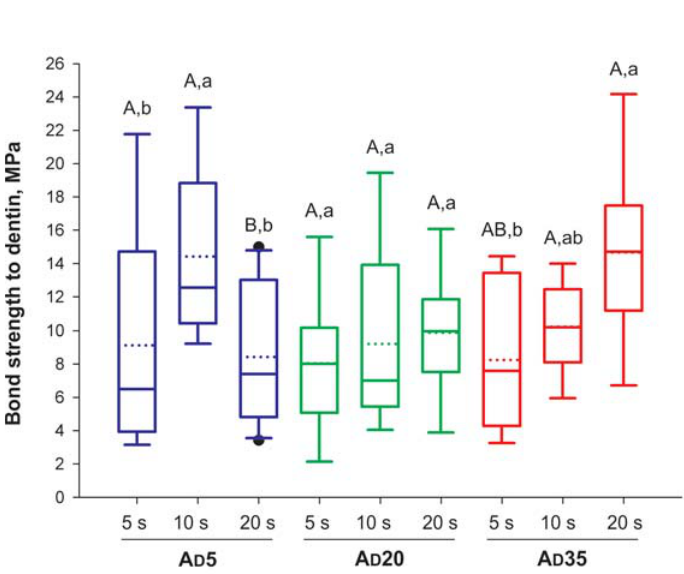
Figure 2- (cid:3)(cid:53)(cid:72)(cid:86)(cid:88)(cid:79)(cid:87)(cid:86)(cid:3)(cid:73)(cid:82)(cid:85)(cid:3)(cid:71)(cid:72)(cid:81)(cid:87)(cid:76)(cid:81)(cid:3)(cid:69)(cid:82)(cid:81)(cid:71)(cid:3)(cid:86)(cid:87)(cid:85)(cid:72)(cid:81)(cid:74)(cid:87)(cid:75)(cid:3)(cid:11)(cid:81)(cid:32)(cid:20)(cid:19)(cid:12)(cid:17)(cid:3)(cid:54)(cid:82)(cid:79)(cid:76)(cid:71)(cid:3)(cid:68)(cid:81)(cid:71)(cid:3)(cid:71)(cid:82)(cid:87)(cid:87)(cid:72)(cid:71)(cid:3)(cid:75)(cid:82)(cid:85)(cid:76)(cid:93)(cid:82)(cid:81)(cid:87)(cid:68)(cid:79)(cid:3)(cid:79)(cid:76)(cid:81)(cid:72)(cid:86)(cid:3)(cid:90)(cid:76)(cid:87)(cid:75)(cid:76)(cid:81)(cid:3)(cid:72)(cid:68)(cid:70)(cid:75)(cid:3)(cid:69)(cid:82)(cid:91)(cid:3)(cid:76)(cid:81)(cid:71)(cid:76)(cid:70)(cid:68)(cid:87)(cid:72)(cid:3)(cid:87)(cid:75)(cid:72)(cid:3)(cid:80)(cid:72)(cid:71)(cid:76)(cid:68)(cid:81)(cid:86)(cid:3)(cid:68)(cid:81)(cid:71)(cid:3)(cid:80)(cid:72)(cid:68)(cid:81)(cid:86)(cid:15)(cid:3) (cid:85)(cid:72)(cid:86)(cid:83)(cid:72)(cid:70)(cid:87)(cid:76)(cid:89)(cid:72)(cid:79)(cid:92)(cid:17)(cid:3)(cid:56)(cid:83)(cid:83)(cid:72)(cid:85)(cid:70)(cid:68)(cid:86)(cid:72)(cid:3)(cid:79)(cid:72)(cid:87)(cid:87)(cid:72)(cid:85)(cid:86)(cid:3)(cid:76)(cid:81)(cid:71)(cid:76)(cid:70)(cid:68)(cid:87)(cid:72)(cid:3)(cid:71)(cid:76)(cid:73)(cid:73)(cid:72)(cid:85)(cid:72)(cid:81)(cid:70)(cid:72)(cid:86)(cid:3)(cid:68)(cid:80)(cid:82)(cid:81)(cid:74)(cid:3)(cid:80)(cid:68)(cid:87)(cid:72)(cid:85)(cid:76)(cid:68)(cid:79)(cid:86)(cid:30)(cid:3)(cid:79)(cid:82)(cid:90)(cid:72)(cid:85)(cid:70)(cid:68)(cid:86)(cid:72)(cid:3)(cid:79)(cid:72)(cid:87)(cid:87)(cid:72)(cid:85)(cid:86)(cid:3)(cid:76)(cid:81)(cid:71)(cid:76)(cid:70)(cid:68)(cid:87)(cid:72)(cid:3)(cid:86)(cid:76)(cid:74)(cid:81)(cid:76)(cid:191)(cid:70)(cid:68)(cid:81)(cid:87)(cid:3)(cid:71)(cid:76)(cid:73)(cid:73)(cid:72)(cid:85)(cid:72)(cid:81)(cid:70)(cid:72)(cid:86)(cid:3)(cid:68)(cid:80)(cid:82)(cid:81)(cid:74)(cid:3)(cid:85)(cid:88)(cid:69)(cid:69)(cid:76)(cid:81)(cid:74)(cid:3)